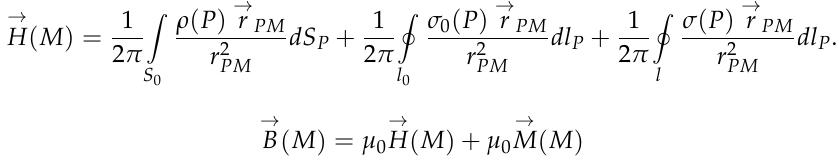
Table 3. Calculation of the potential on the segment L of the upper face of the ferromagnet after calculating the distribution  .